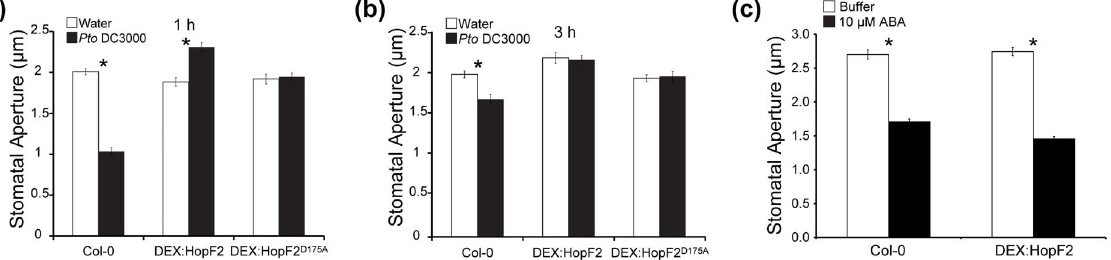
Fig. 3. Transgenic expression of HopF2 results in altered stomatal immunity. Four week old Col-0 or transgenic Arabdiopsis expressing HopF2 or HopF2 D175A under the control of a dexamethasone inducible promoter were sprayed with 30 m M dexamethasone. Leaf discs were prepared 24 hours